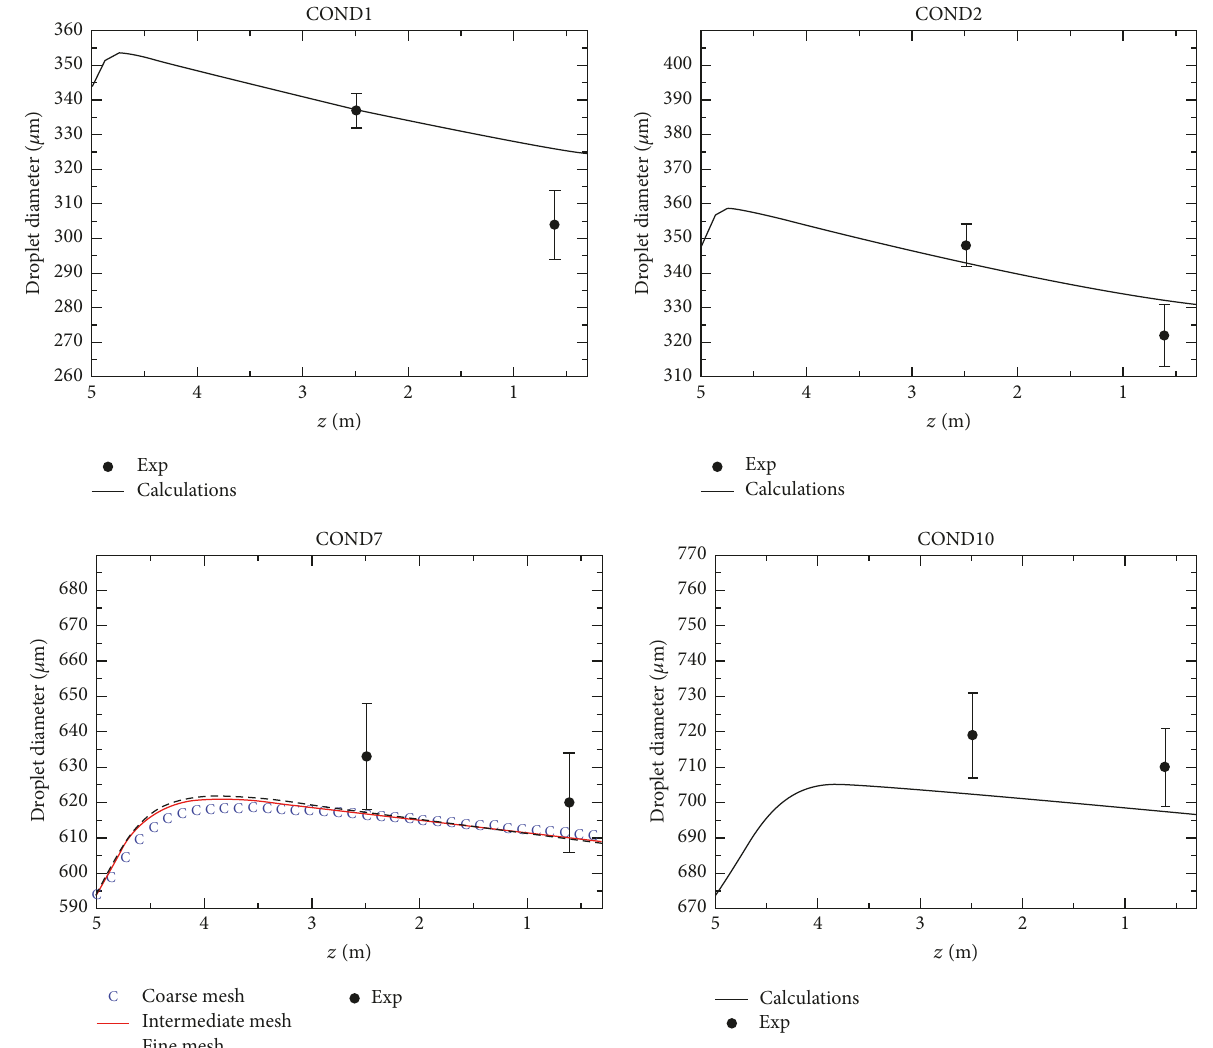
Figure 16: Droplet diameter versus elevations, condensation